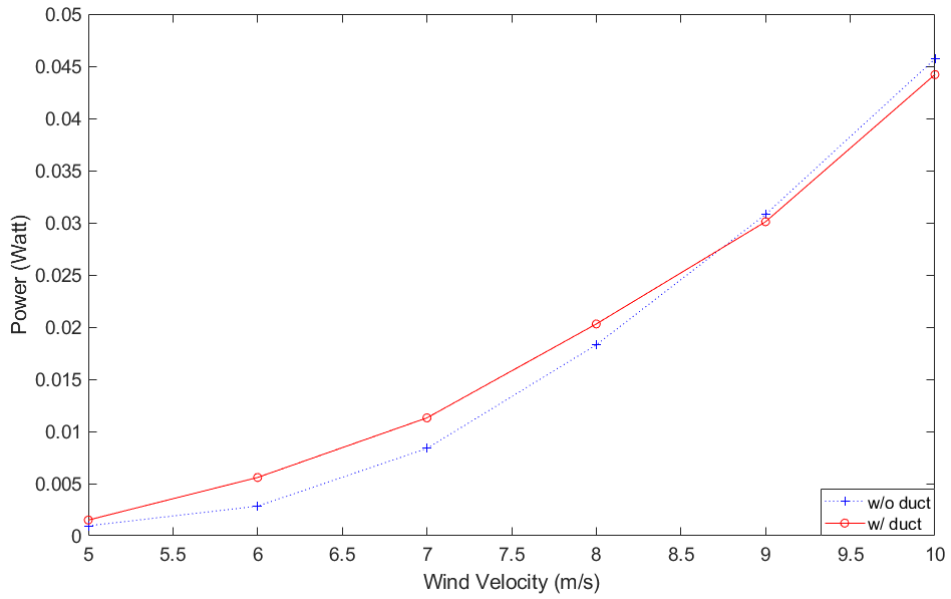
Figure 8. Power generation performance of micro wind energy harvesters with and without ducts.